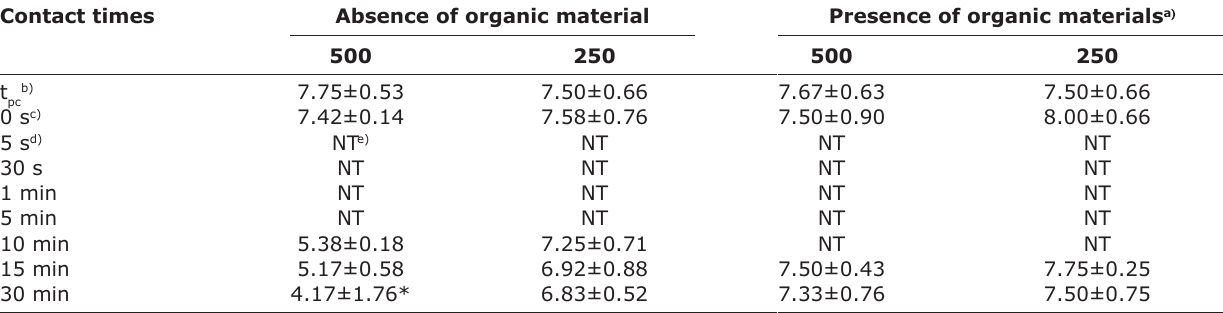
Table-4: The virucidal efficacy against AIV at 4°C. Contact times